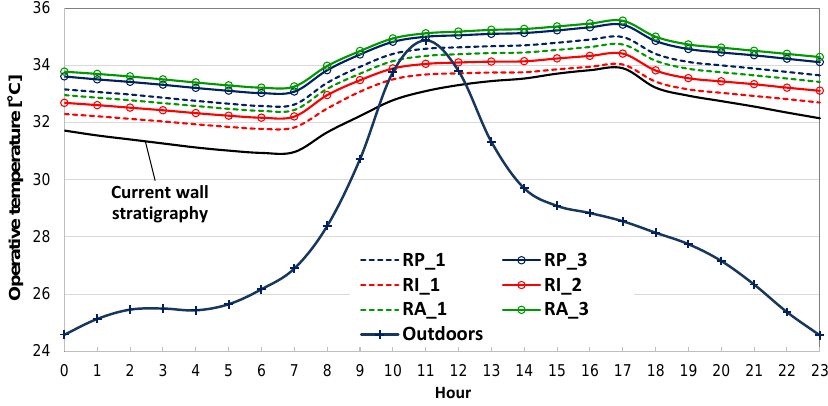
Figure 6. Operative temperature profile on the hottest day (9th of August, East-facing office).